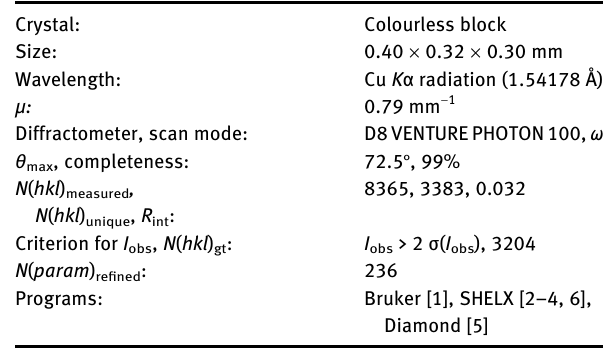
Table  : Data collection and